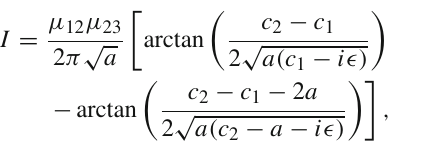
kinematic variables are given by